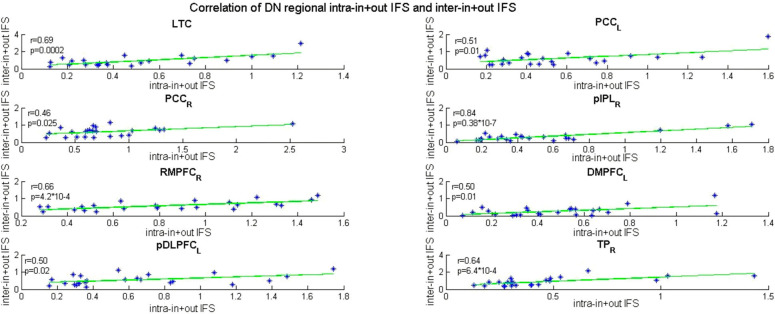
Correlation of decreased DN regional intra-in+out IFS and inter-in+out IFS in AD subjects (P < 0.05, uncorrected for multiple comparisons). LTC, lateral temporal cortex; PCC, posterior cingulate cortex; pIPL, posterior inferior parietal lobule; RMPFC, rostromedial prefrontal cortex; DM, dorsomedial prefrontal cortex; pDLPFC, posterior dorsolateral prefrontal cortex; TP, temporopolar cortex; L, left hemisphere; R, right hemisphere; r, Pearson correlation coefficient.